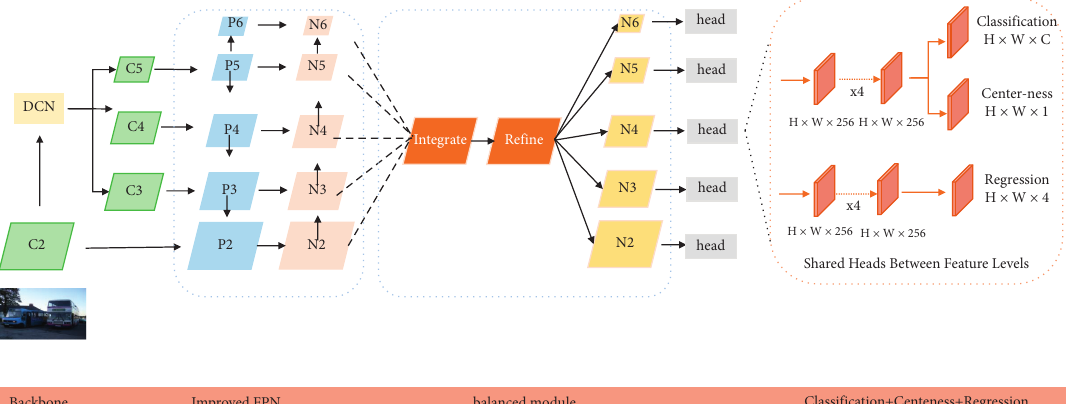
Figure 1: Improved FCOS algorithm structure: we clearly show all the tricks in the original picture for easy reading. Among them, C2 ∼ C5 are the feature layers output by the backbone, the first N2 ∼ N6 are the improved FPN, and the second is the result of adding local